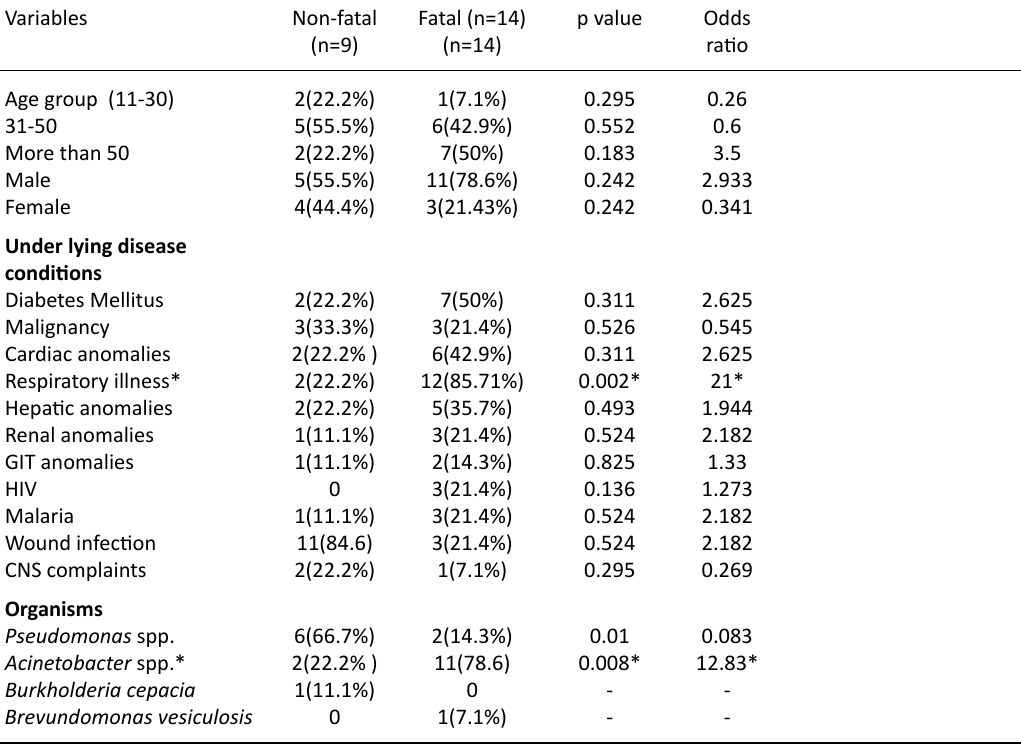
Table 4. Correlation of underlying clinical conditions with fatal outcome